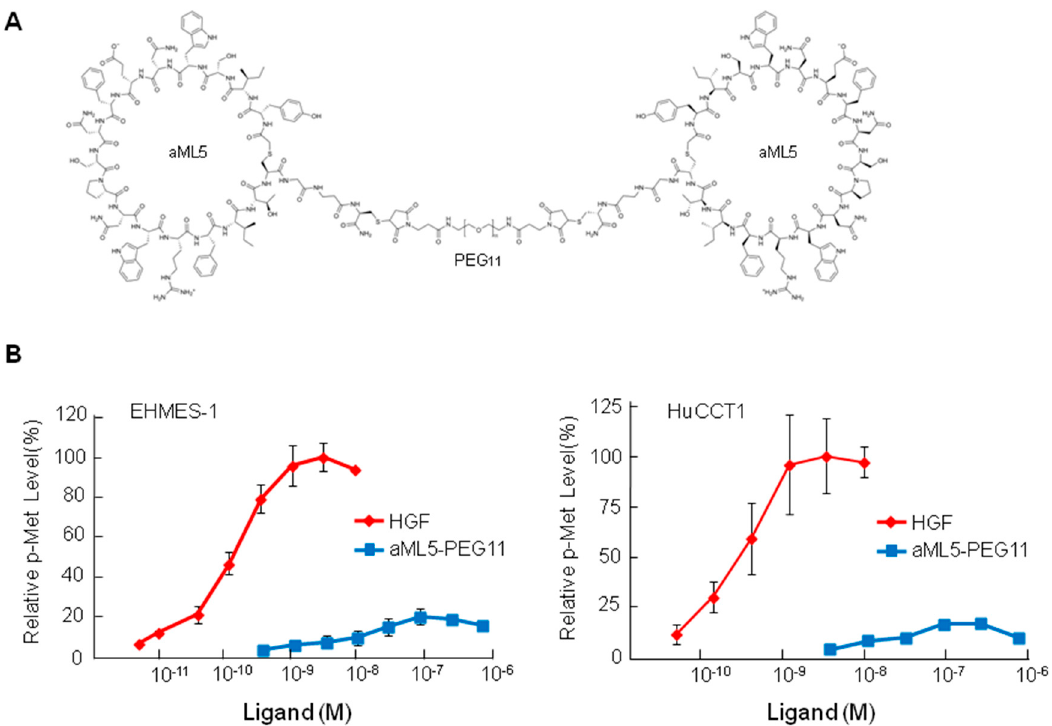
Figure 1. Chemical structure of aML5-PEG11 and MET receptor activation by aML5-PEG11. ( A ) Structure of aML5-PEG11. ( B ) MET receptor activation by aML5-PEG11. EHMES-1 and HuCCT1 cells were treated with aML5-PEG11 or HGF for 10 minutes. MET receptor phosphorylation at Tyr 1234/1235 was quantified by using a cell-based phospho-MET receptor assay. Each value indicates the mean ± SD obtained from independent experiments performed in triplicate.